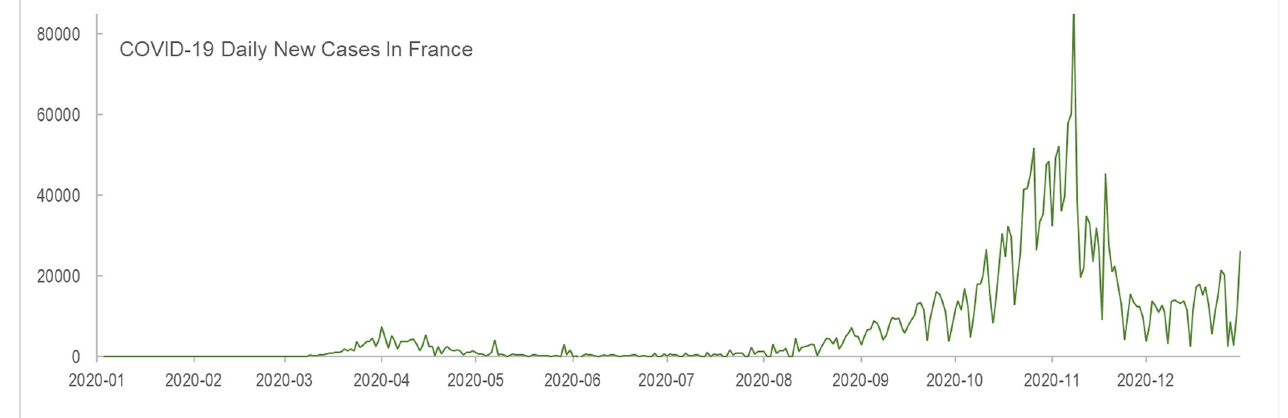
Fig 15. Daily COVID-19 new cases in France in 2020. (Data source: World Health Organization Coronavirus Dashboard, https://covid19.who.int/info/. Accessed on March 19, 2021).